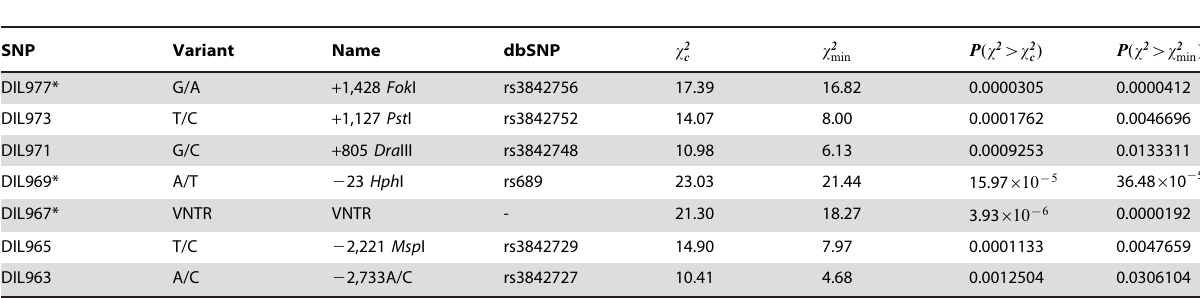
Table 17. The Significant SNPs at 5% significance level when the MITDT-ONE is applied.